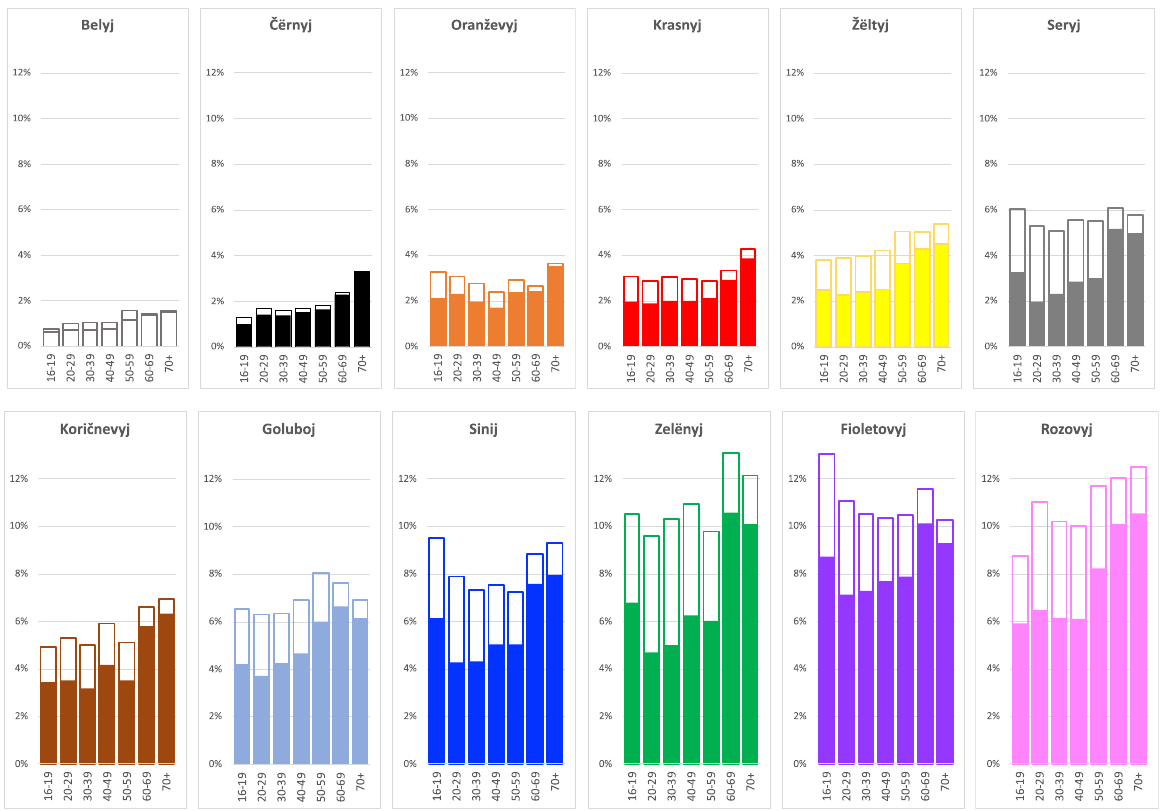
Fig. 8 Percentage of occurrences of the 12 Russian BCTs (dark shades) along with their modi fi ed and compounded forms (light shades) in color names of participants of the seven age groups. The BCTs are ordered according to the frequency of responses, from lowest (left) to highest